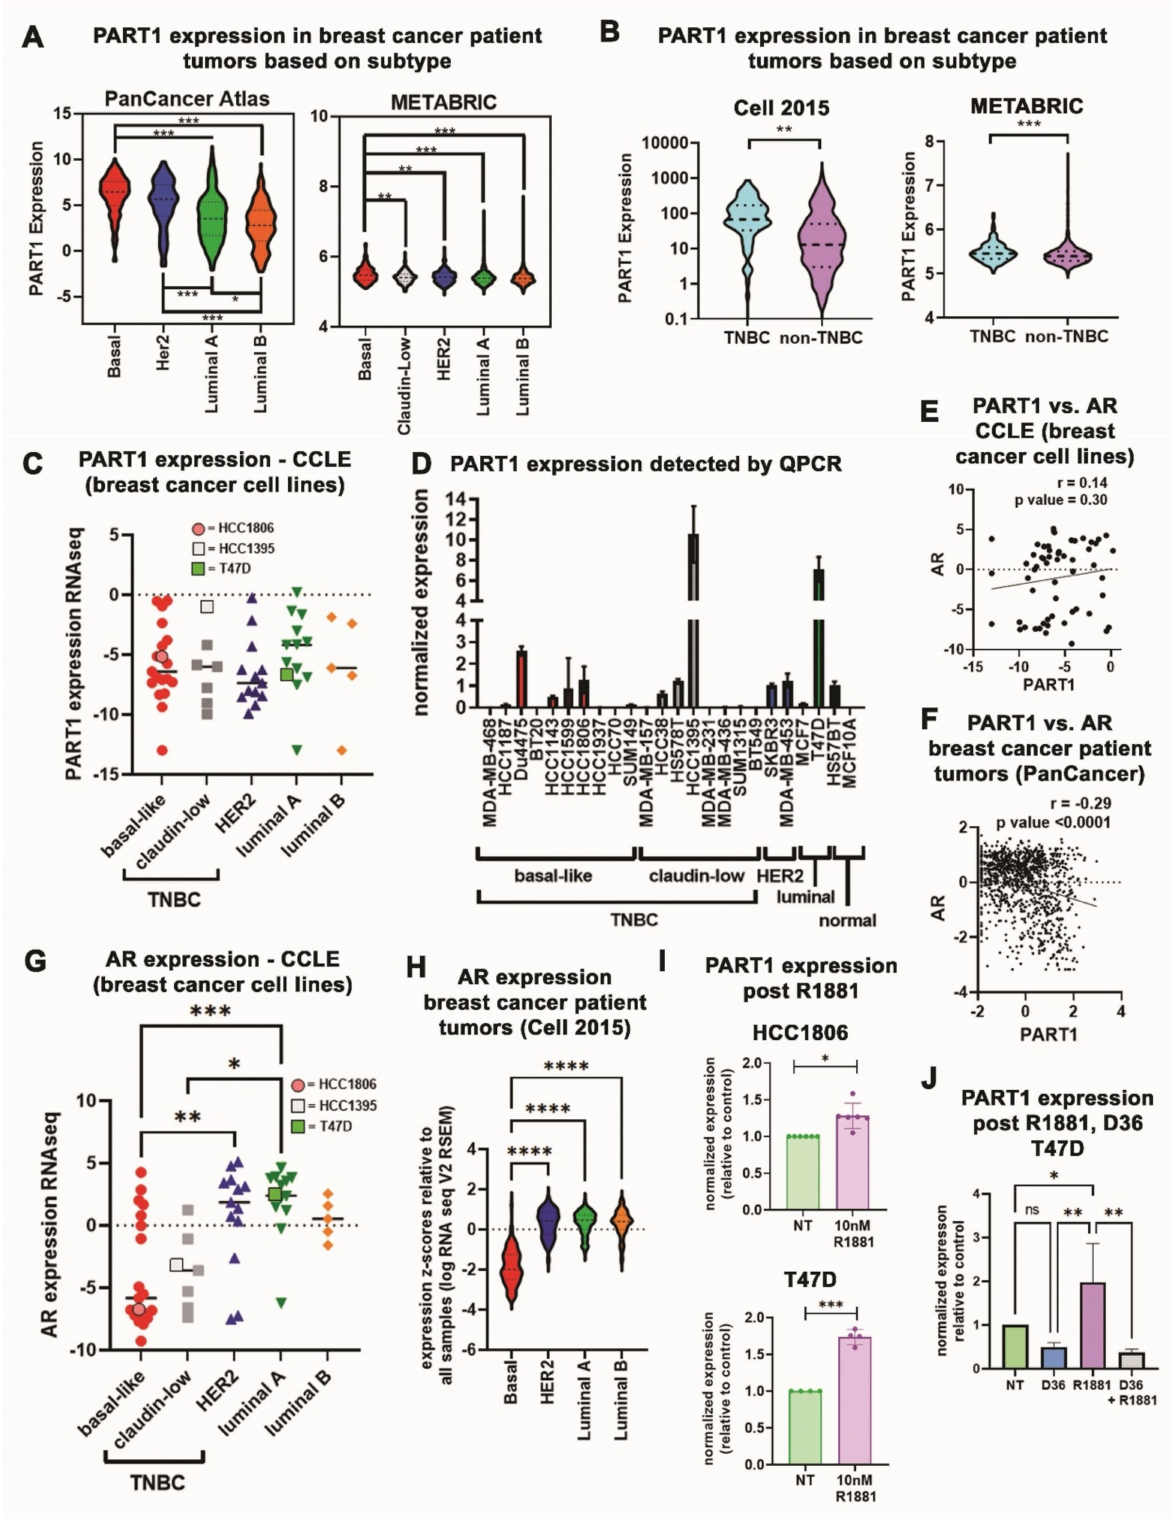
Figure 1. PART1 expression is enriched in TNBC patient tumors and is induced by androgenic molecules in breast cancer cells. ( A , B ) PART1 expression in breast cancer patient tumor cohorts based on molecular intrinsic subtypes, PAM50 or claudin-low ( A ) or TNBC status ( B ). Gene expression information was extracted from the TCGA PanCancer Atlas and Cell 2015 (RNA-seq) and the METABRIC (microarray) datasets via cBioPortal (1 May 2020). Significance comparing TNBC versus non-TNBC groups was determined using an unpaired two-tailed t -test, while comparisons of multiple groups